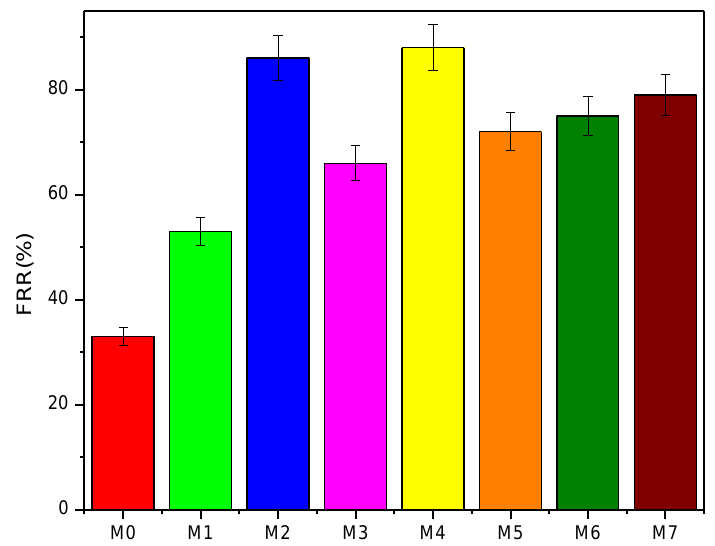
Figure 16. Water flux recovery ratios of the TFC membranes. In addition to FRR, membrane fouling on the surface or inside its pores is also assessed using reversible, irreversible and total fouling calculations [64]. These parameters are indicative of how foulants interact with or attached to the membrane. Reversible fouling occurs when foulants are loosely bound to the membrane and therefore can be easily removed through a sufficient shear force or backwashing. However, it is a different